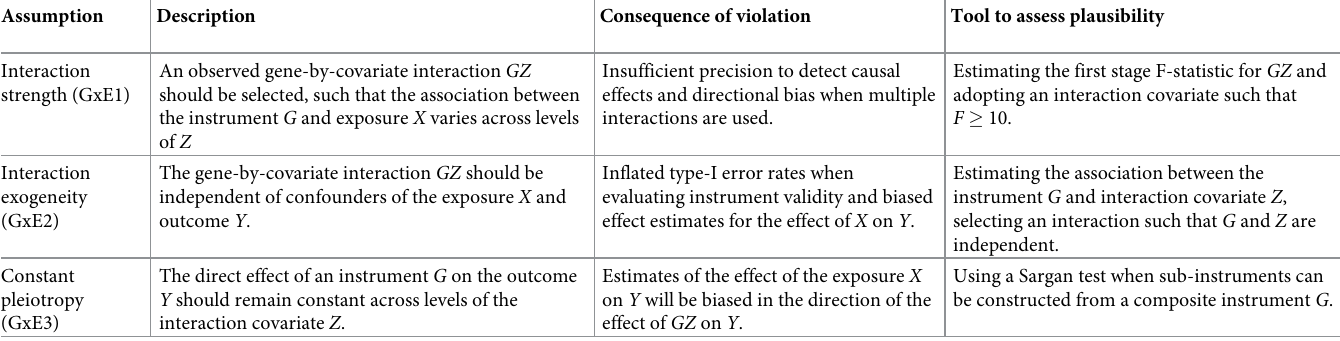
Table 6. A summary of the MR-GxE assumptions and proposed sensitivity